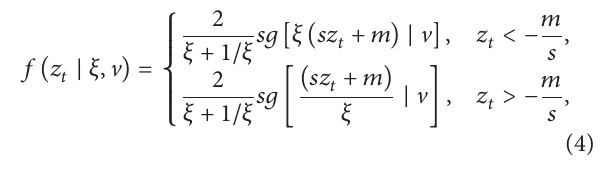
− 𝜇 ∗ ) for right-skewed oep,rgt oep,nml